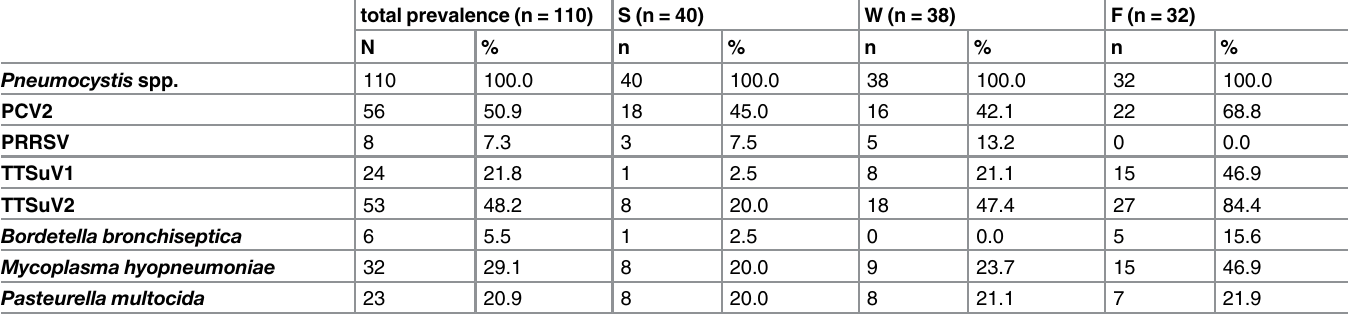
Table 2. Detection rates of all investigated pathogens in Pneumocystis positive lung samples and their relation to age groups. S = suckling piglets, W = weaning piglets, F = fattening pigs; n = number of samples. total prevalence (n = 110) S (n = 40) W (n = 38) F (n = 32) N % n % n % n % Pneumocystis spp. 110 100.0